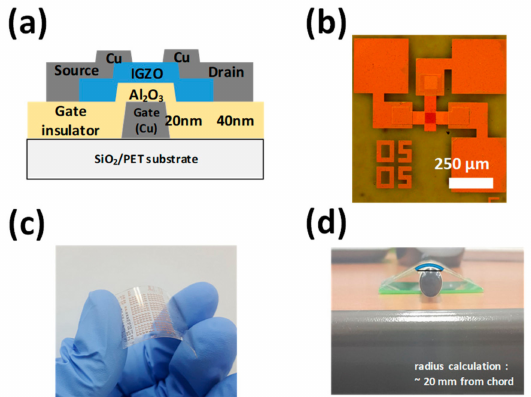
Figure 1. ( a ) Schematic cross-sectional image of the flexible indium-gallium-zinc oxide (IGZO) thin-film transistor (TFT) fabricated on the polyethylene terephthalate (PET) substrate. ( b ), ( c ) Photographic images of the fabricated flexible IGZO TFT. ( d ) Photographic image of the customized bending plate with a ~20 mm bending